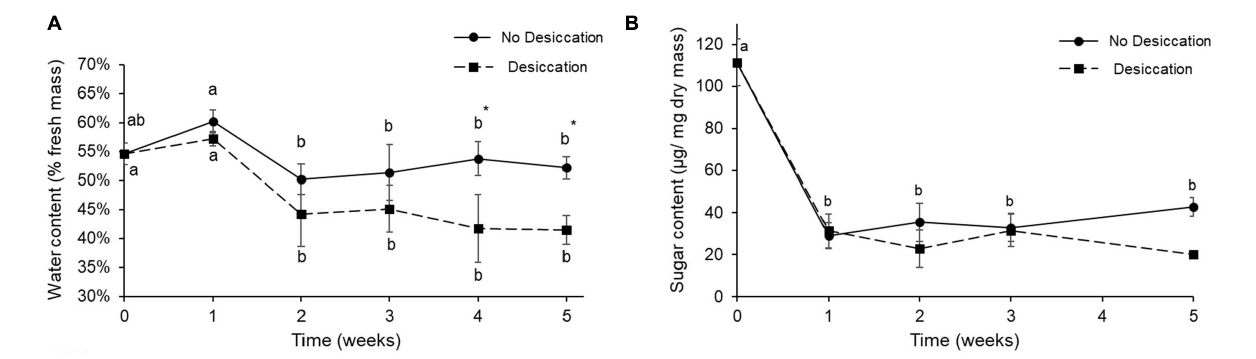
FIGURE 2 | Water content (mean ± SD) (A) and sugar content (Mean ± SD) (B) of food-deprived insects kept at 10 ± 2% RH (desiccation treatment, dotted line and black squares) and control insects kept at 60% RH (no desiccation, solid line, and black dots). For each treatment, letters denote significant differences over the duration of the experiment. Stars (*) indicate significant differences between the two treatments at each time point (two-way